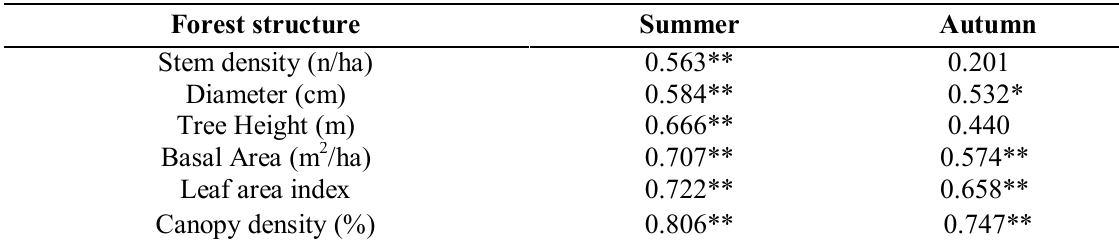
Table 4. Pearson correlation coefficients between PCI and vegetation structure in different seasons ( n = 33, p <